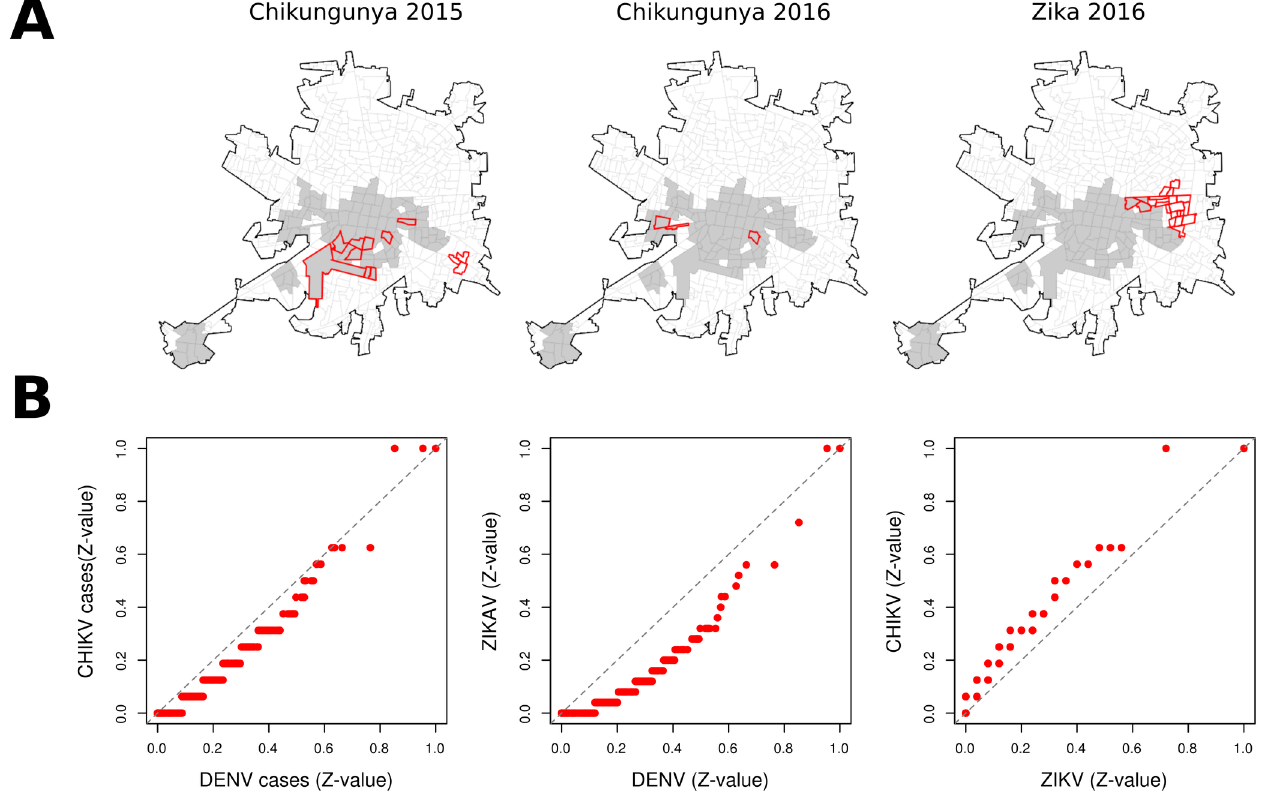
Fig 3. Spatial pattern of arbovirus hot-spots in Merida. (A) Hot-spots of CHIKV (2015–2016) and ZIKV (2016) standardized case counts overlapped with persistent DENV clustering area (gray polygons represent persistent DENV clustering areas and red polygons represent statistically significant yearly hot- spots for CHIKV and ZIKV). (B) Q-Q plots comparing distribution of standardized case counts of DENV, CHIKV, and ZIKV. Source of the census tract boundaries was INEGI,